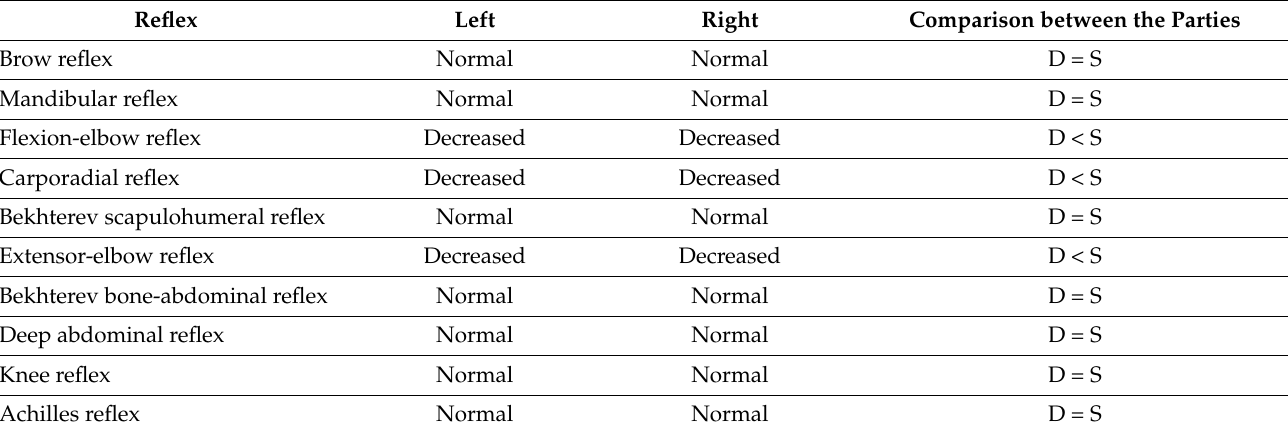
Table 1. Tendon and periosteal reflexes.